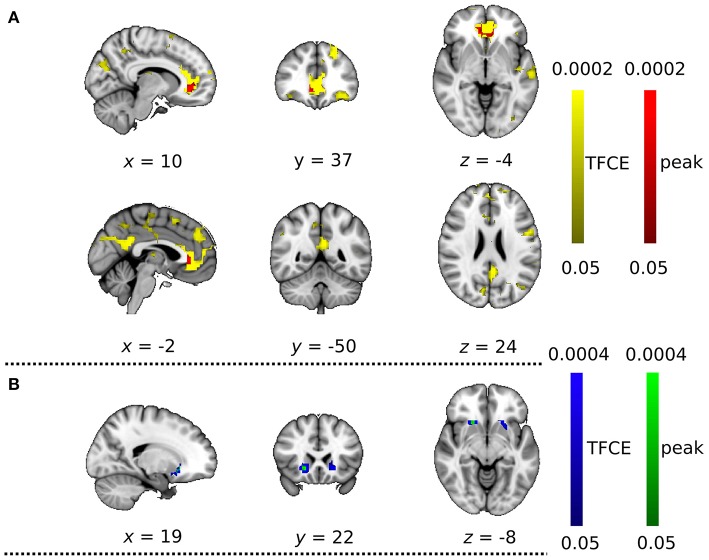
Functional connectivity with field map correction greater than that without correction as revealed by the dual regression analysis. (A) Anterior default mode network and (B) basal ganglia network. Colored clusters indicate significantly increased connectivity after field map correction thresholded by threshold-free cluster enhancement (TFCE) (YELLOW or BLUE) and thresholded by peak (height)-based method (RED or GREEN) (both after multiple comparison familywise error correction across voxels, components of interest, and contrast; p < 0.05).